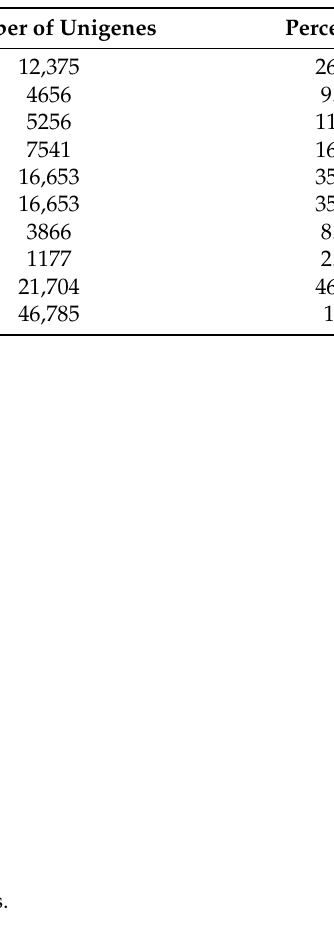
Table 1. Gene annotation success rate statistics.